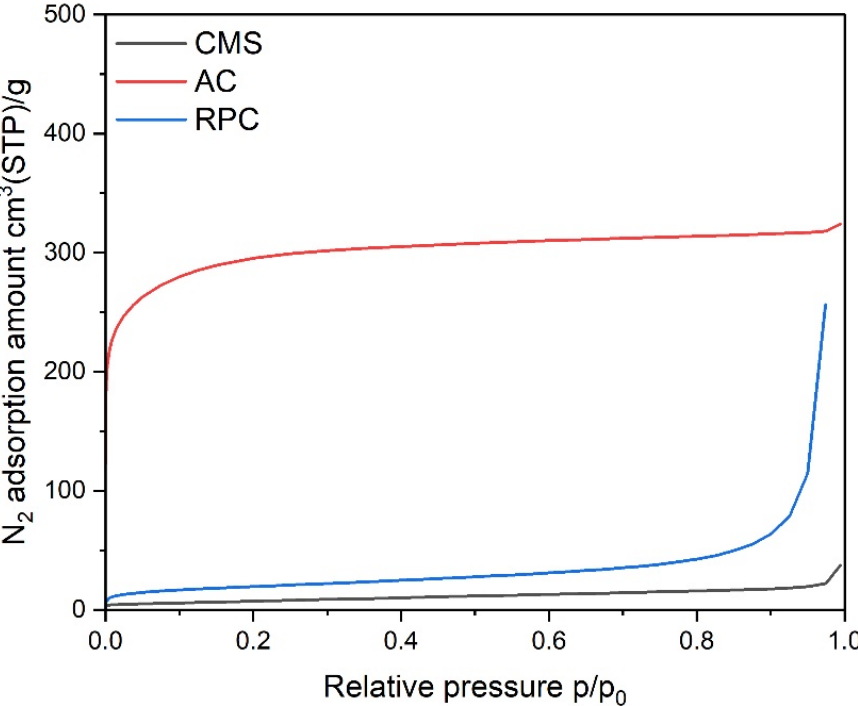
Figure 1. Isotherms of N 2 adsorption on the investigated samples.